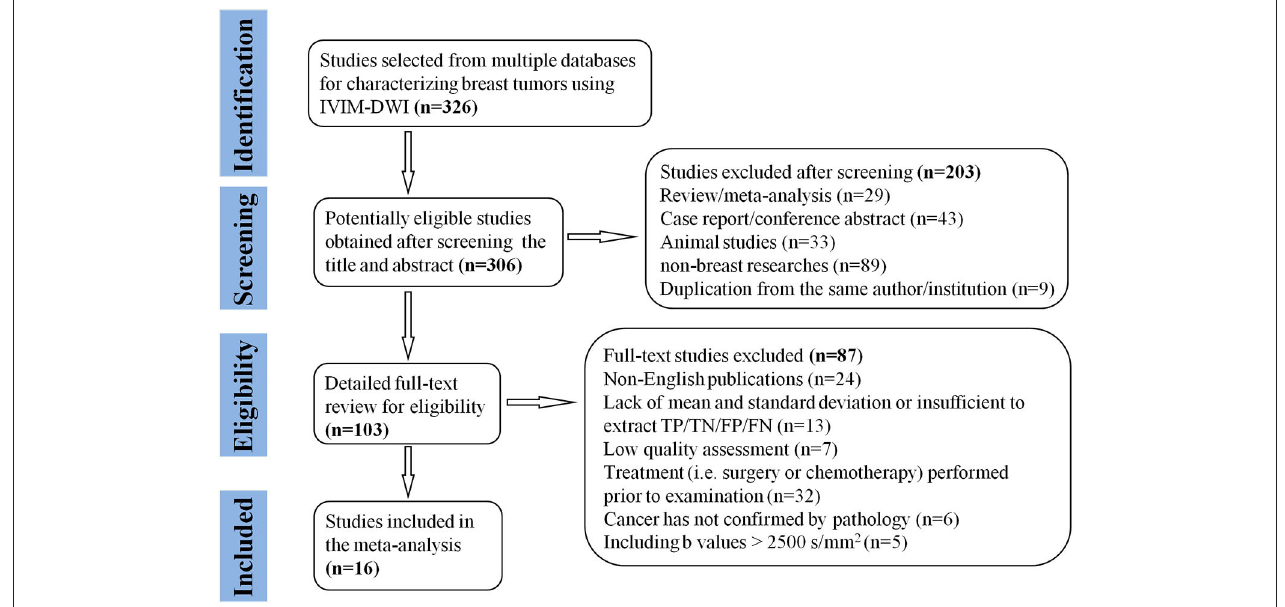
FIGURE 1 | Flowchart detailing the study selection process. Sixteen studies met the inclusion criteria. FN, false negative; FP, false positive; TN, true negative; TP, true positive.